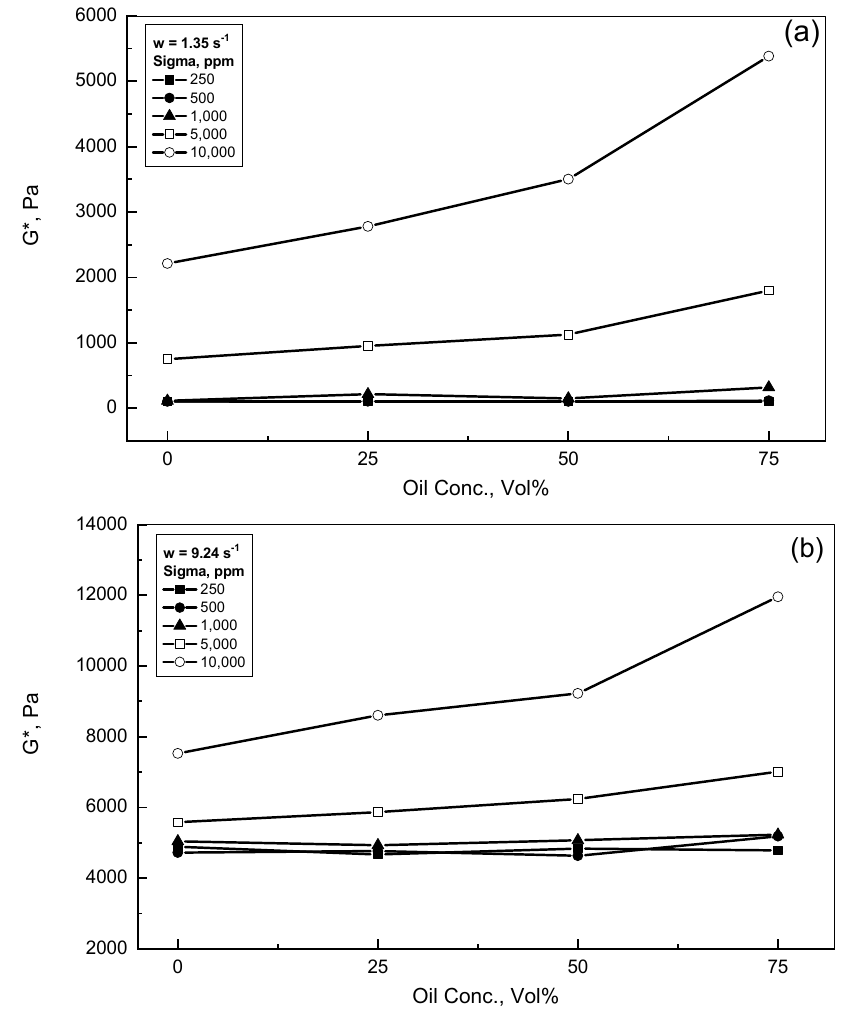
Figure 5. Effect of crude oil addition on G* behavior. ( a ) w = 1.35 s − 1 ; ( b ) w = 9.24 s − 1